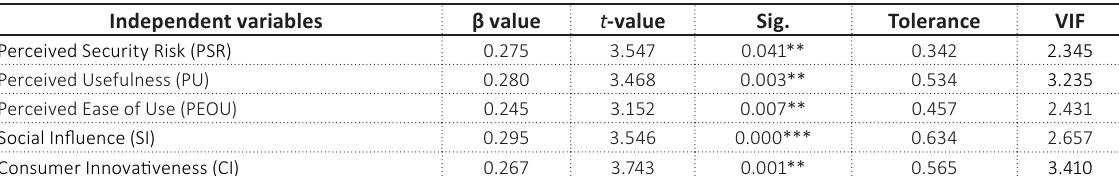
Table 2. Regression analysis